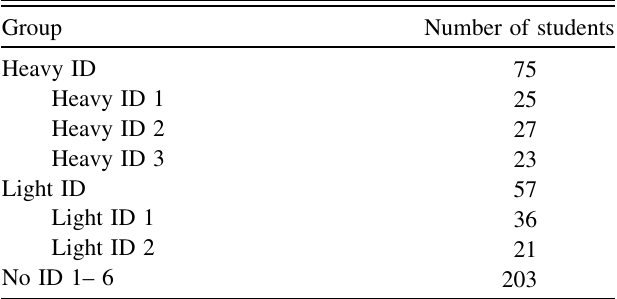
DOES USING A VISUAL-REPRESENTATION TOOL . . TABLE I. Groups and students participating in the study ( n ¼ 335 ).